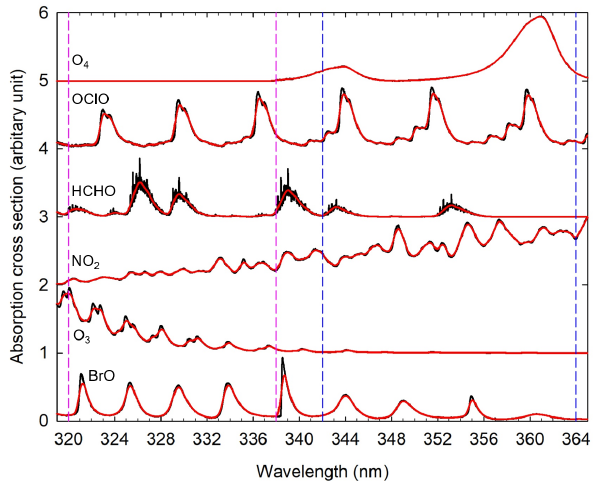
Figure 1. Reference absorption cross sections used in the sensitivity test of DOAS BrO retrieval. The spectra have been scaled to the order of 1 for presentation purposes. Black lines are the original cross sections and red lines are absorption cross sections convolved with the TROPOMI slit function (TROPOMI ISRF calibration key data v1.0.0). Pink vertical dashed lines indicate start wavelength ranges and blue lines end wavelength ranges of fitting windows for this sensitivity